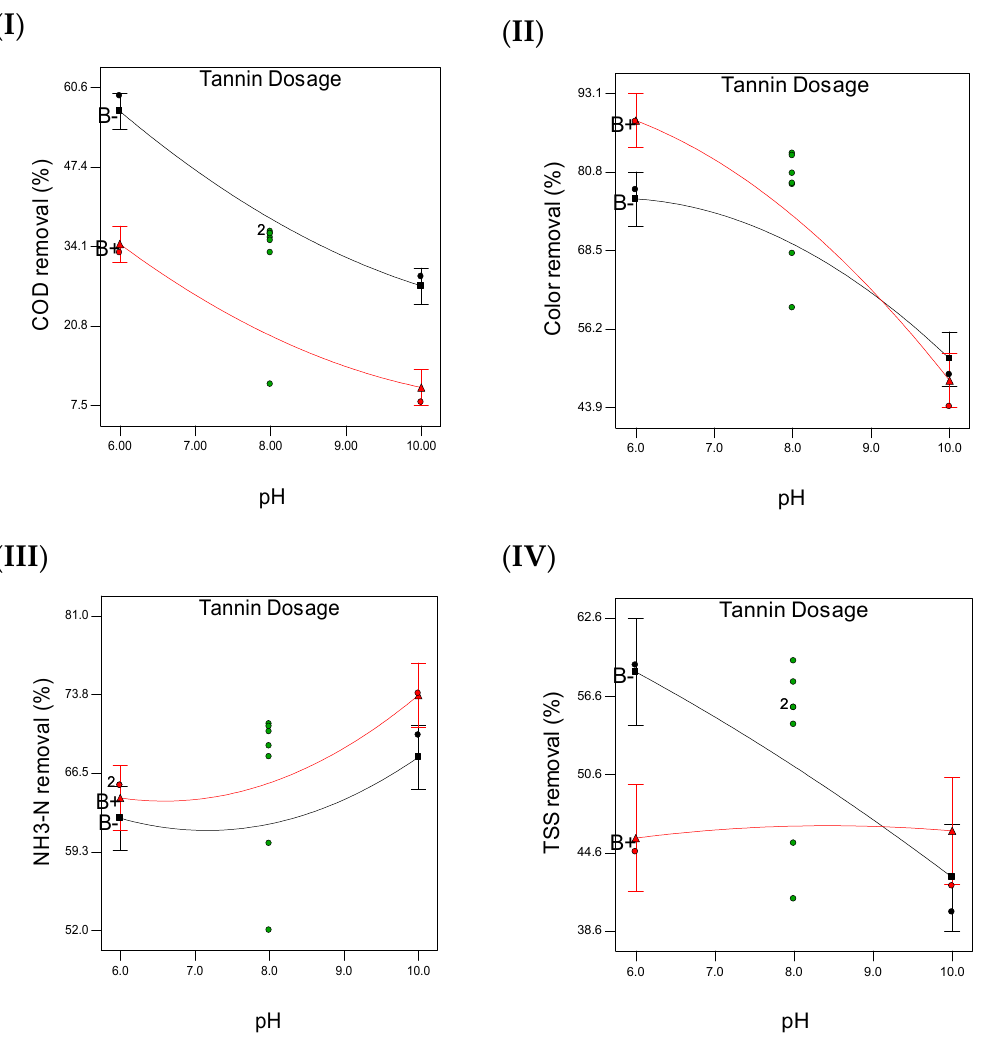
Figure 7. The effect of Interaction between tannin dosage and pH for: ( I ) COD, ( II ) color, ( III ) NH 3 -N and ( IV) TSS removal during coagulation of landfill leachate (B − : represents the low level of tannin dosage, B+: represents the high level of tannin dosage and: represents the design point).